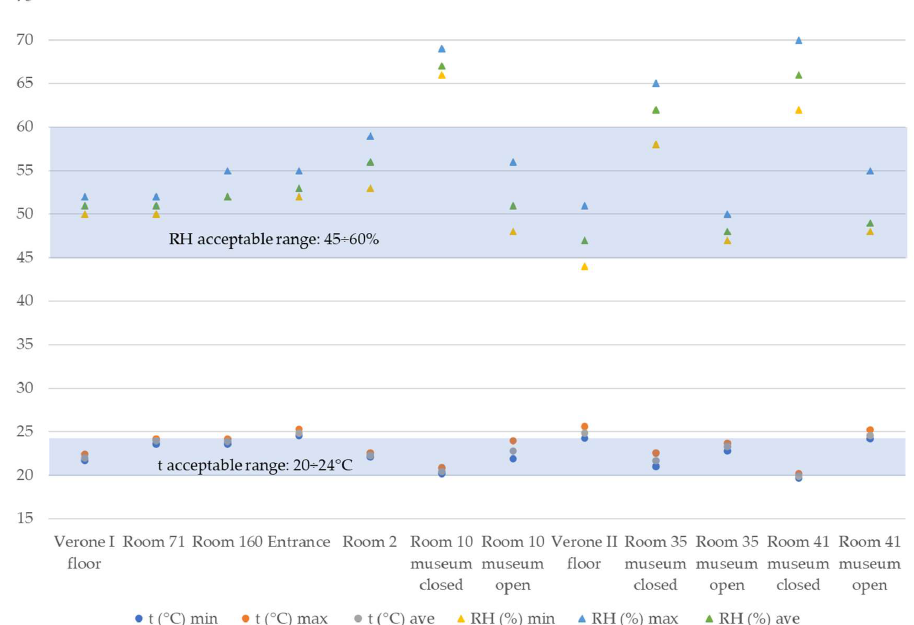
Figure 6. Minimum, average and maximum measured values for temperature (t [°C]) and relative humidity (RH [%]) compared together with recommended values.